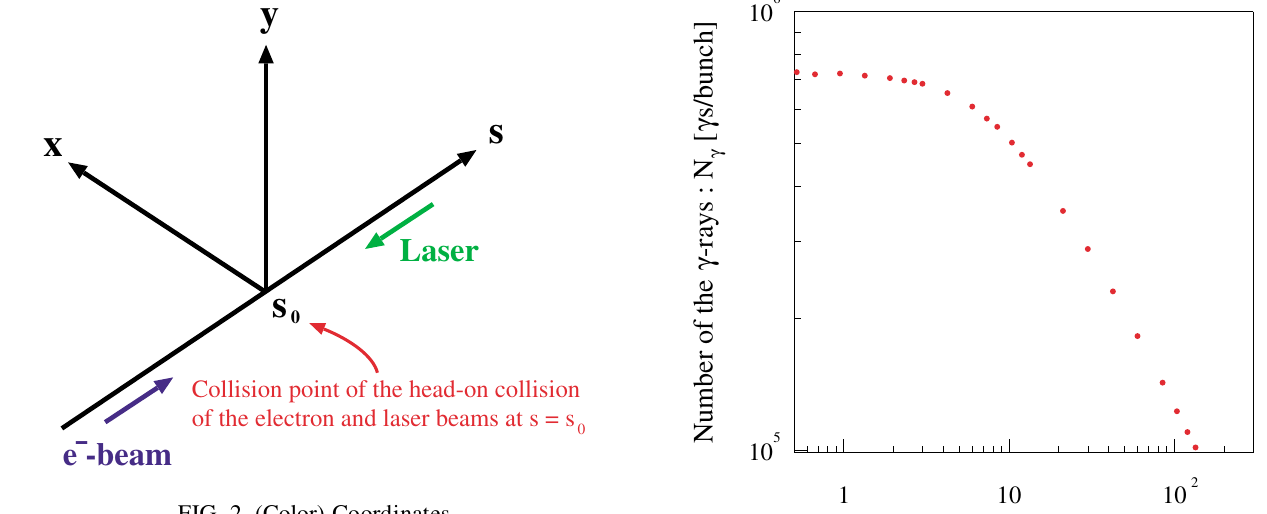
FIG. 2. (Color) FIG. 4. (Color) Expected number of (cid:1) rays as a function of the horizontal e (cid:1) -beam size calculated by the numerical model.